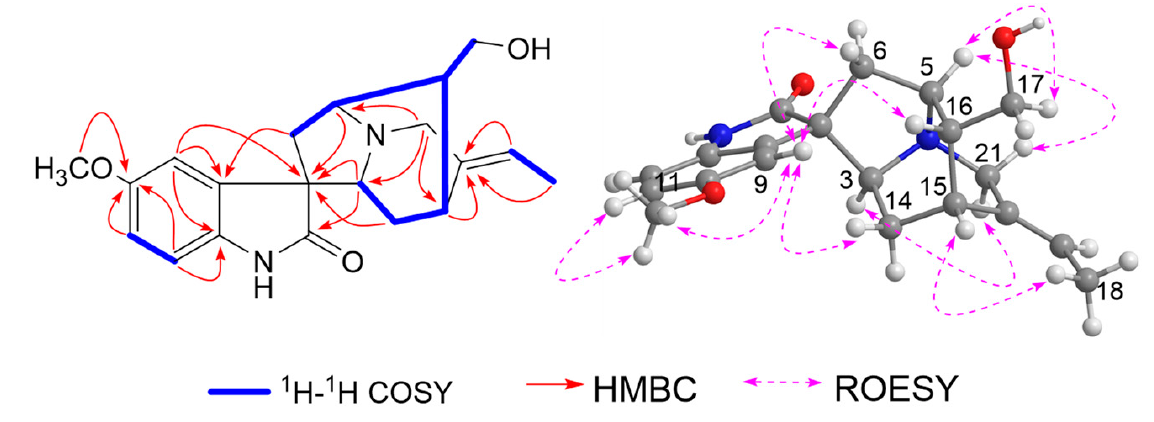
Figure 2. Key 1 H– 1 H COSY, HMBC and ROESY correlations of 1 .